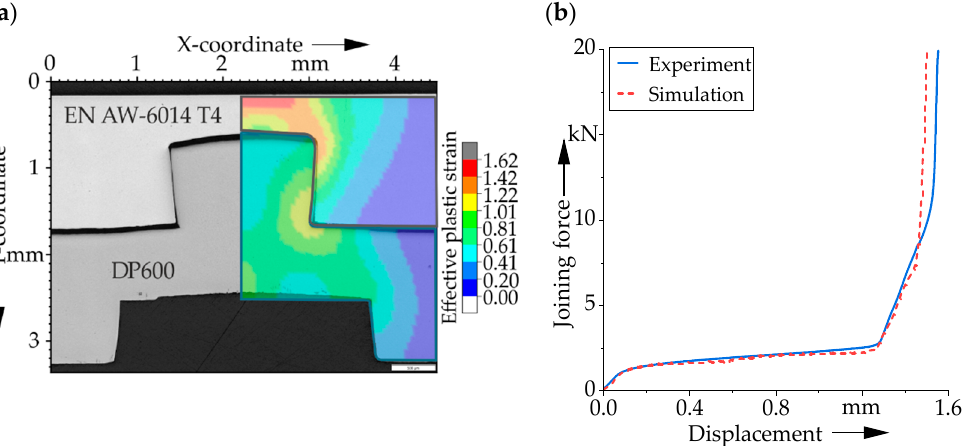
Figure 8. ( a ) The comparison of the geometric properties of a direct pin pressing joint using a micrograph of a pin with a height, h, of 1.38 mm from a sheet of DP600 with a thickness of t 0 = 1.5 mm and an aluminium joining partner of EN AW-6014-T4 with a thickness of t 0 = 1.5 mm, and the results of the numerical simulation with corresponding parameters. ( b ) Numerically determined and experimentally measured force-displacement curves for direct pin pressing. Table 1. Uniformly distributed input